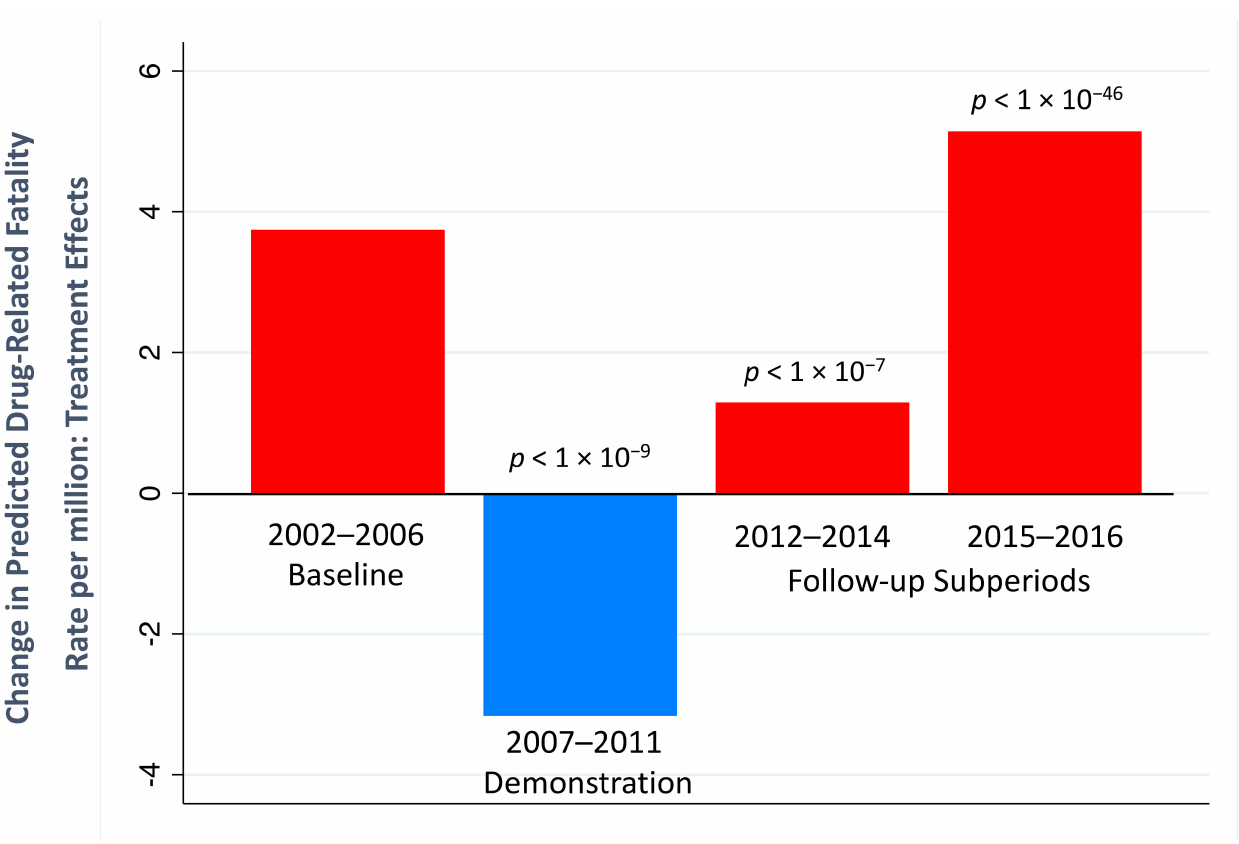
Figure 4. ITS treatment effects for demonstration and follow-up periods. The left red bar shows the change in regression predicted value for the monthly drug-related fatality rate ( dfr ) during the baseline 2002–2006. The blue bar shows the significant ITS treatment effect (TE 1 ) for the demonstration period. TE 1 < 0 supports Hypothesis 1, indicating a total reduction in the regression predicted value for dfr relative to the baseline trend. The first red bar on the right shows the significant TE 2 for the 2012–2014 follow-up subperiod. TE 2 > 0 supports Hypothesis 2, indicating a total 2012–2014 increase in the predicted value of dfr relative to the demonstration-period trend. Likewise, the significant TE 3 > 0 (right red bar) supports Hypothesis 2, indicating a 2015–2016 total increase in the predicted value of dfr relative to the demonstration-period